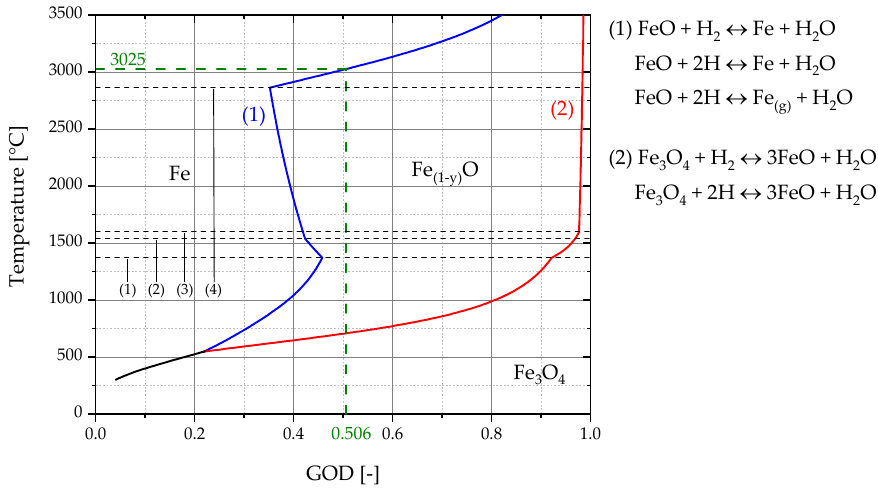
Figure 26. Baur–Glaessner diagram calculated with FactSage TM 8.0. Database: FToxid, FactPS.